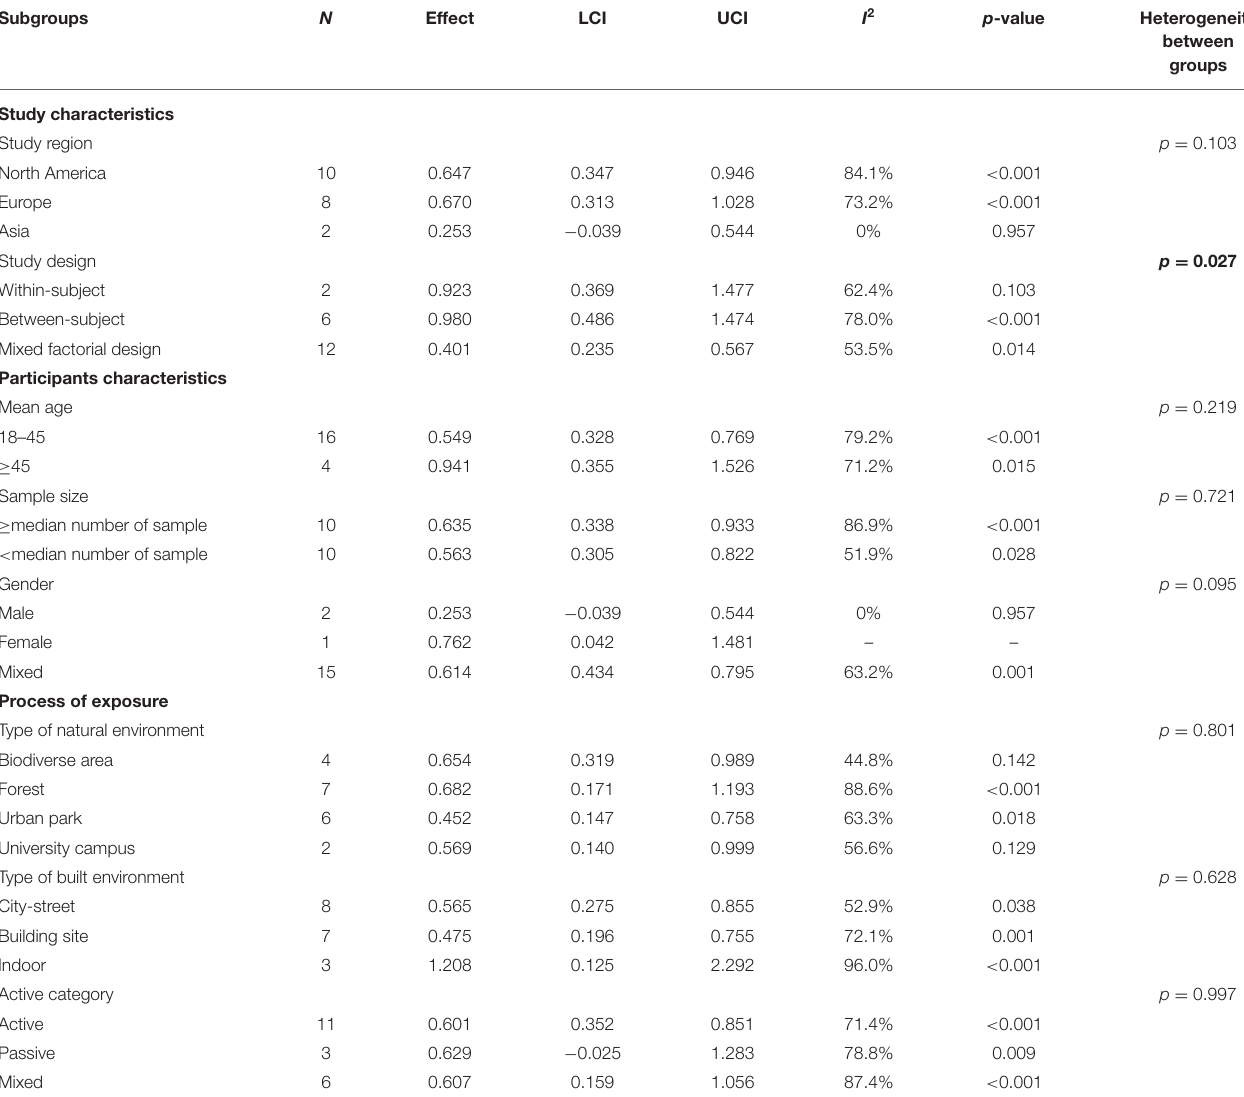
TABLE 2 | Summary of subgroup analysis of positive affect studies ( n = 20) conducted by study characteristics, participants characteristics, and process of exposure. Subgroups Heterogeneity